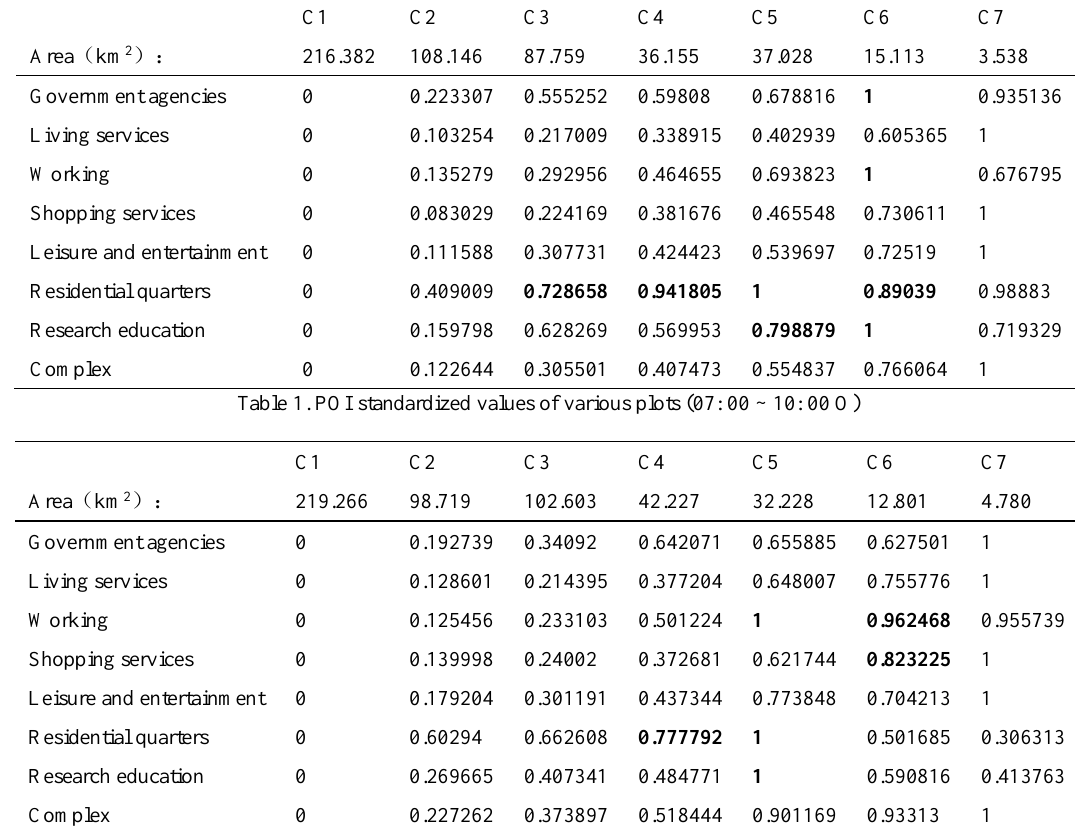
Table 2. POI standardized values of various plots (07: 00 ~ 10: 00